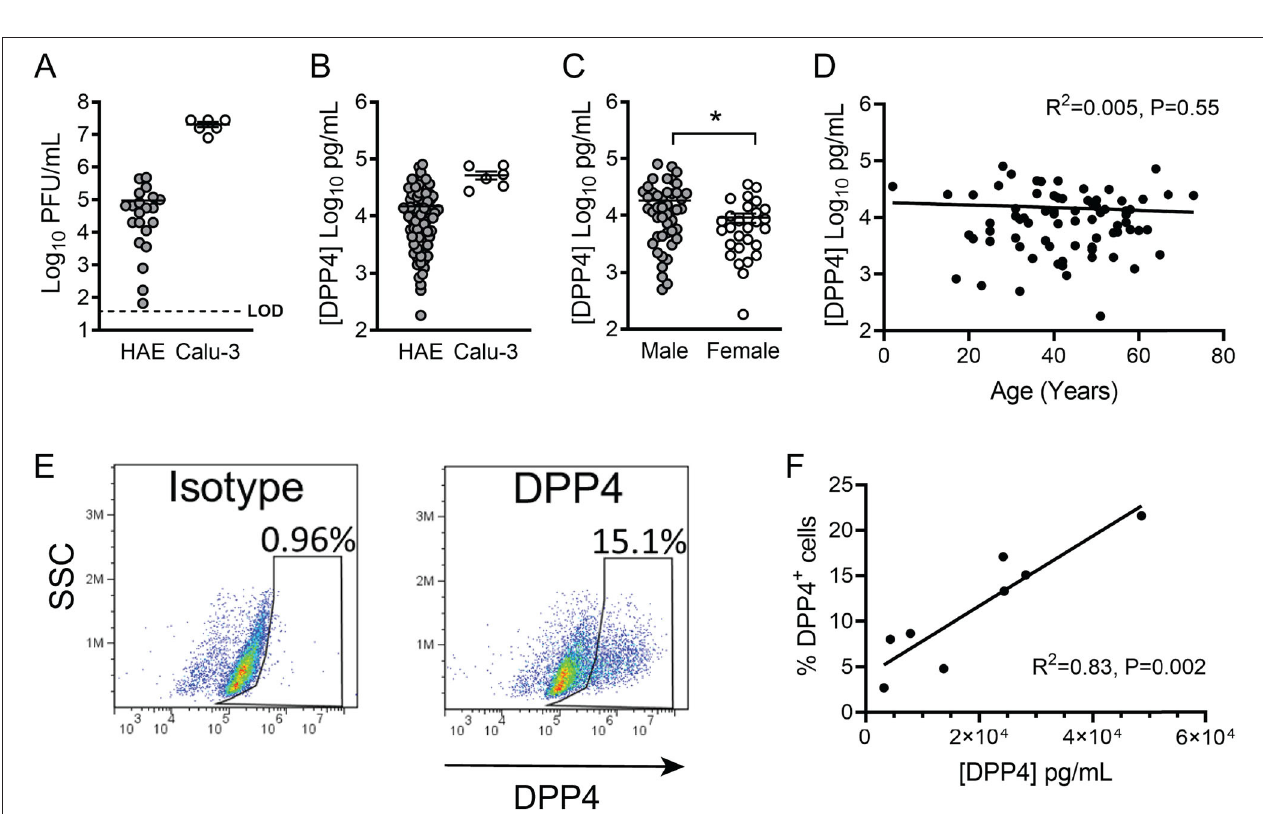
FIGURE 1 | Asterisks denote statistically significant differences between infected ciliated vs. non-ciliated cells at each time point, as determined by performing multiple unpaired t -tests with Welch correction. * P < 0.05; **** P < 0.0001. (D) Mucus was removed from the apical surface of HAE cultures by incubation with 10mM DTT followed by PBS rinses, as described in Methods. HAE cultures with or without mucus removed were then infected apically with MERS-CoV (MOI = 0.1). The total numbers of infected ciliated and non-ciliated cells were counted at 1 day post infection for the mucus replete (No wash) and mucus-depleted (DTT) conditions (4 fields/HAE donor x 3 donors). Mann-Whitney test was performed to test for significant differences between the No wash and DTT conditions for each cell type (ns = not significant). (E) HAE ( n = 7 donors) were infected with MERS-CoV (MOI = 0.1), with and without mucus removal, and plaque assay was used to measure release of viral progeny at 1 day post infection. Each data point represents results from a single HAE donor. The Wilcoxon matched-pairs signed rank test was used to test for significant differences between paired titer data (No wash vs. DTT) for each HAE donor * P < 0.05.